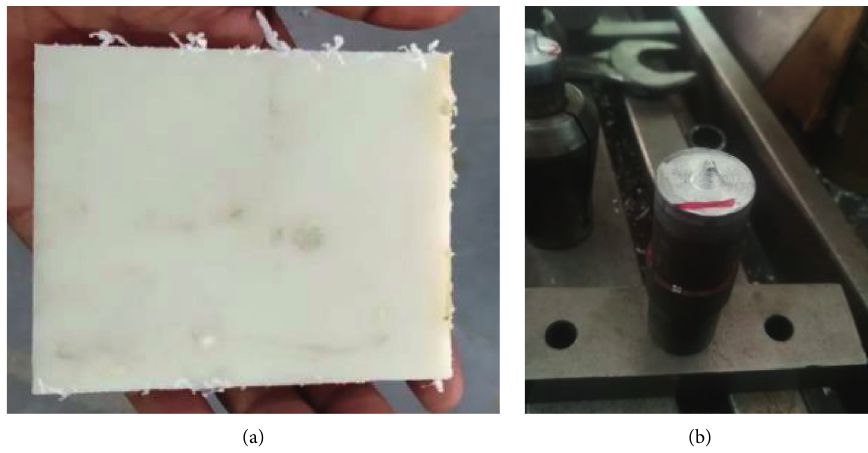
Figure 3: (a) Raw material of nylon. (b) Taper threaded tool.